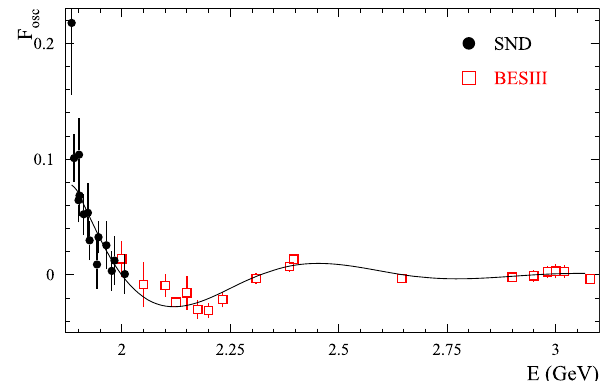
Fig. 17 The deviation of the neutron effective form factor data from the dipole formula [see Eq. (13)]. The curve is the result of the fit to the SND and BESIII neutron data described in the